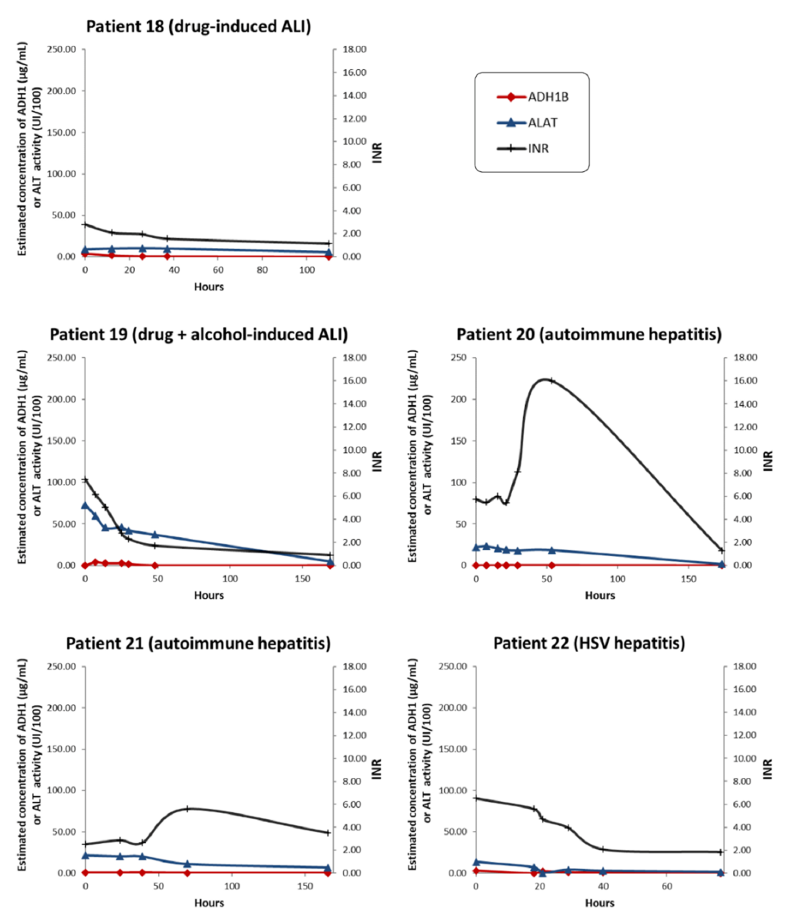
Figure 5. Time-dependent changes in liver injury biomarkers in patients with non-acetaminophen- induced ALI/ALF. ADH1B serum concentration was determined via quantitative LC–SRM. ALI/ALF etiology is indicated on each graph. The INR is reported as an indicator of coagulation defects. Serum ALT activity is also indicated for comparison. Data points were connected using a smoothed line.